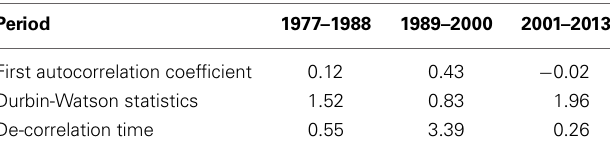
Table 2 | Different statistical properties of the analysis of autocorrelation function for the three analyzed